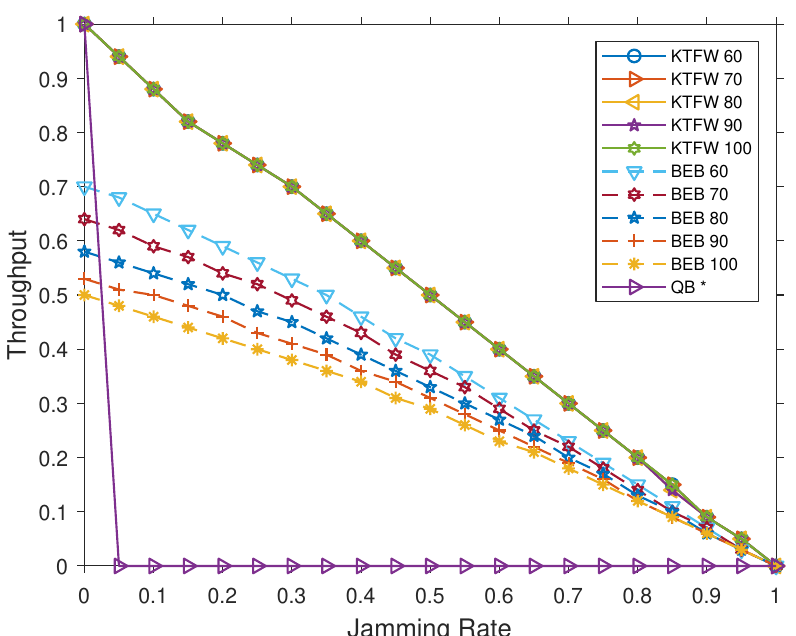
Figure 10. Comparing the throughput of the KTFW and the BEB algorithms for all jamming rates and n ∈